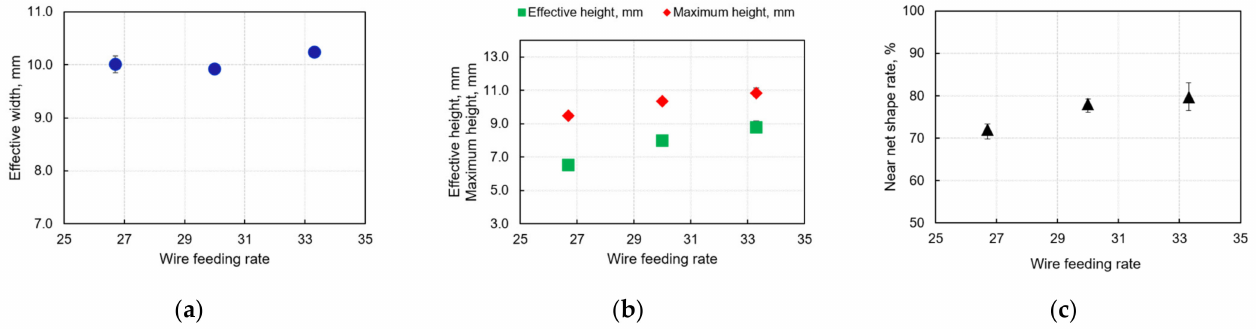
Figure 9. Cross-sectional characteristics of ( a ) effective width, ( b ) effective height and maximum height, and ( c ) near net shape rate, for laser power of 5.5 kW and process speed of 0.36